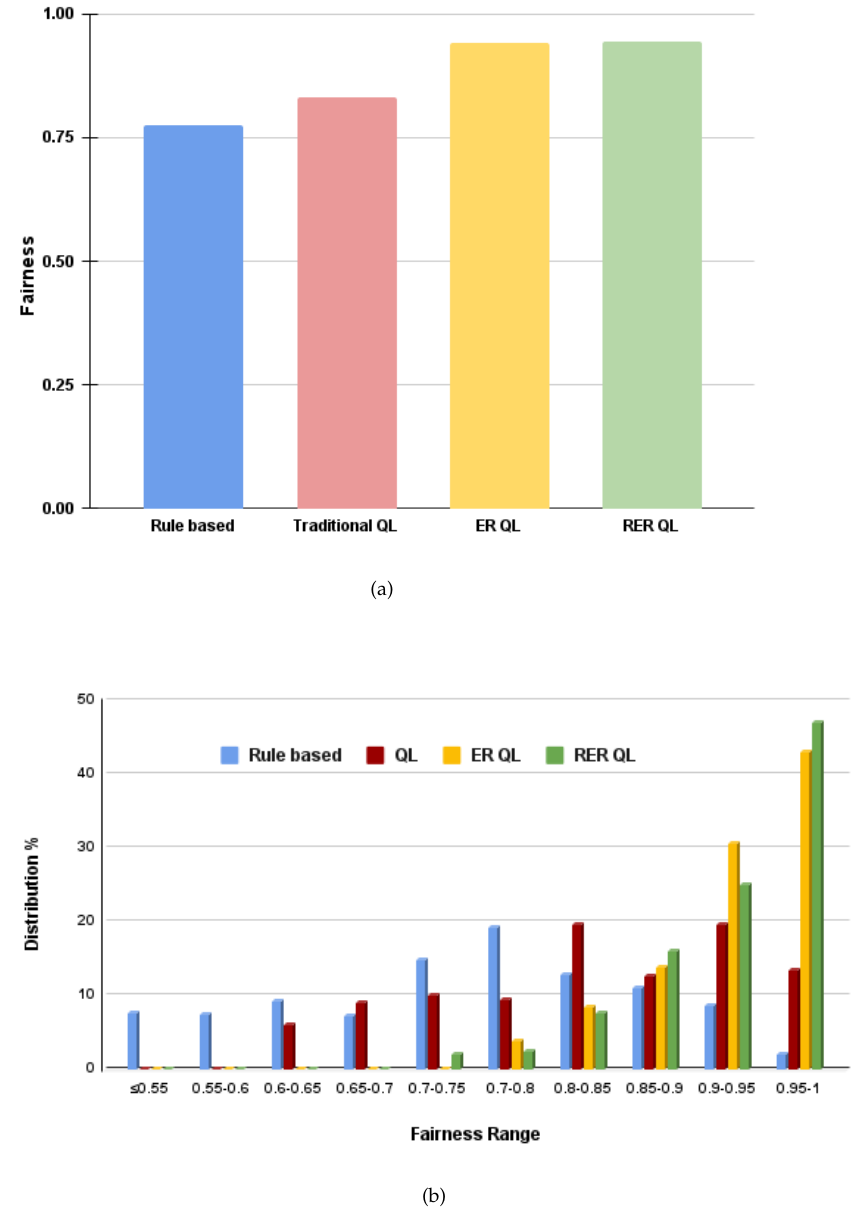
Figure 5. Comparison of fairness for the proposed solutions ( a ) average fairness ( b ) histogram of fairness values obtained in each fixed load duration in the entire simulation